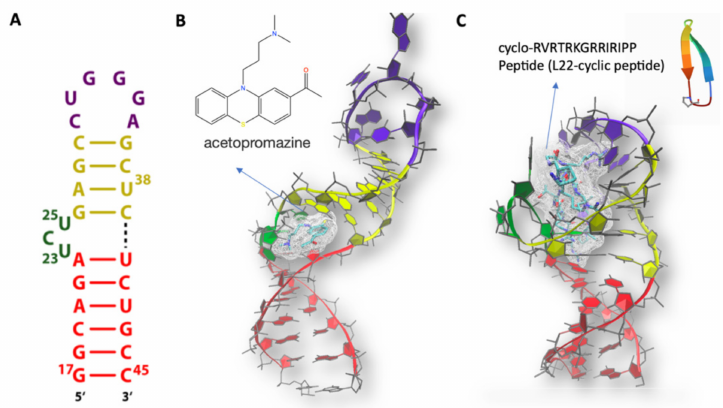
Figure 3. ( A ) HIV TAR secondary structure. The apical loop, bulge, and the upper and lower stems are colored in magenta, green, yellow, and red, respectively. ( B ) NMR structure (PDBID 1LVJ [95]) of HIV TAR in complex with 1-[10-(3-DIMETHYLAMINO-PROPYL)-10H-PHENOTHIAZIN-2-YL]- ETHANONE (Acetylpromazine). ( C ) NMR structure of HIV TAR (PDBID 2KDQ [97] in complex with L-22 CYCLIC PEPTIDE. The same color code as in A is used in B and C for HIV